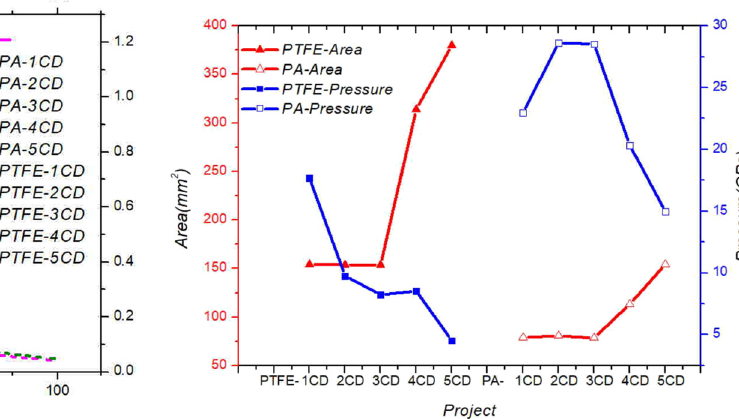
Figure 12: Curve of internal energy of sandwich charge with time. Figure 13: Curve of initial contact area and pressure with stando ff